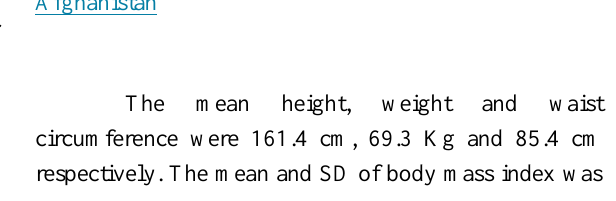
Table 1: Participant characteristics among those surveyed using the WHO STEPS in Jalalabad, Nangarhar,